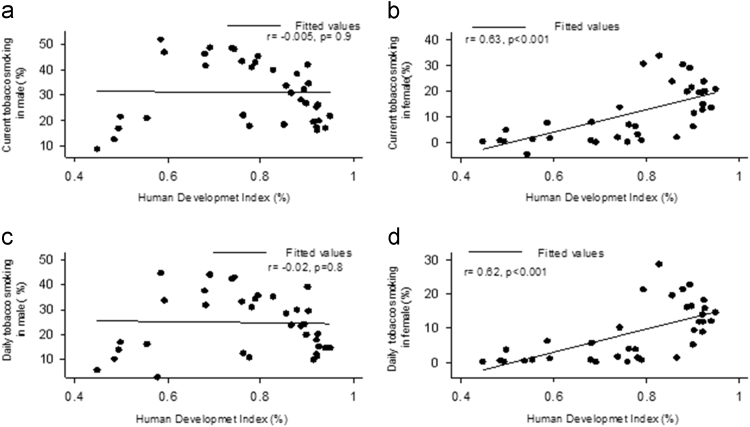
Correlation between HDI and prevalence of tobacco smoking. a: current tobacco smoking in men, b: current tobacco smoking in woman c: daily tobacco smoking in men d: daily tobacco smoking in women.